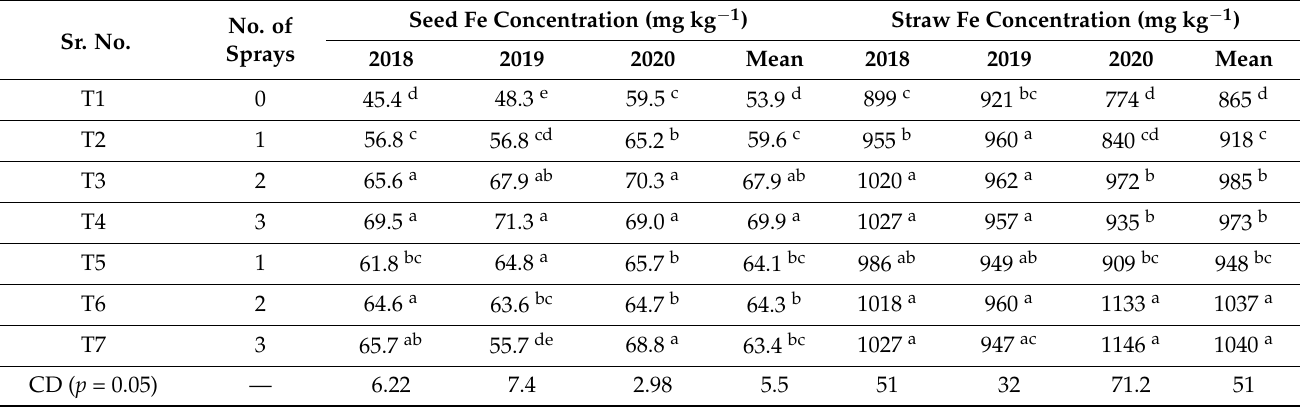
Table 3. Impact of foliar application of FeSO 4 · 7H 2 O on Fe concentration of soybeans.